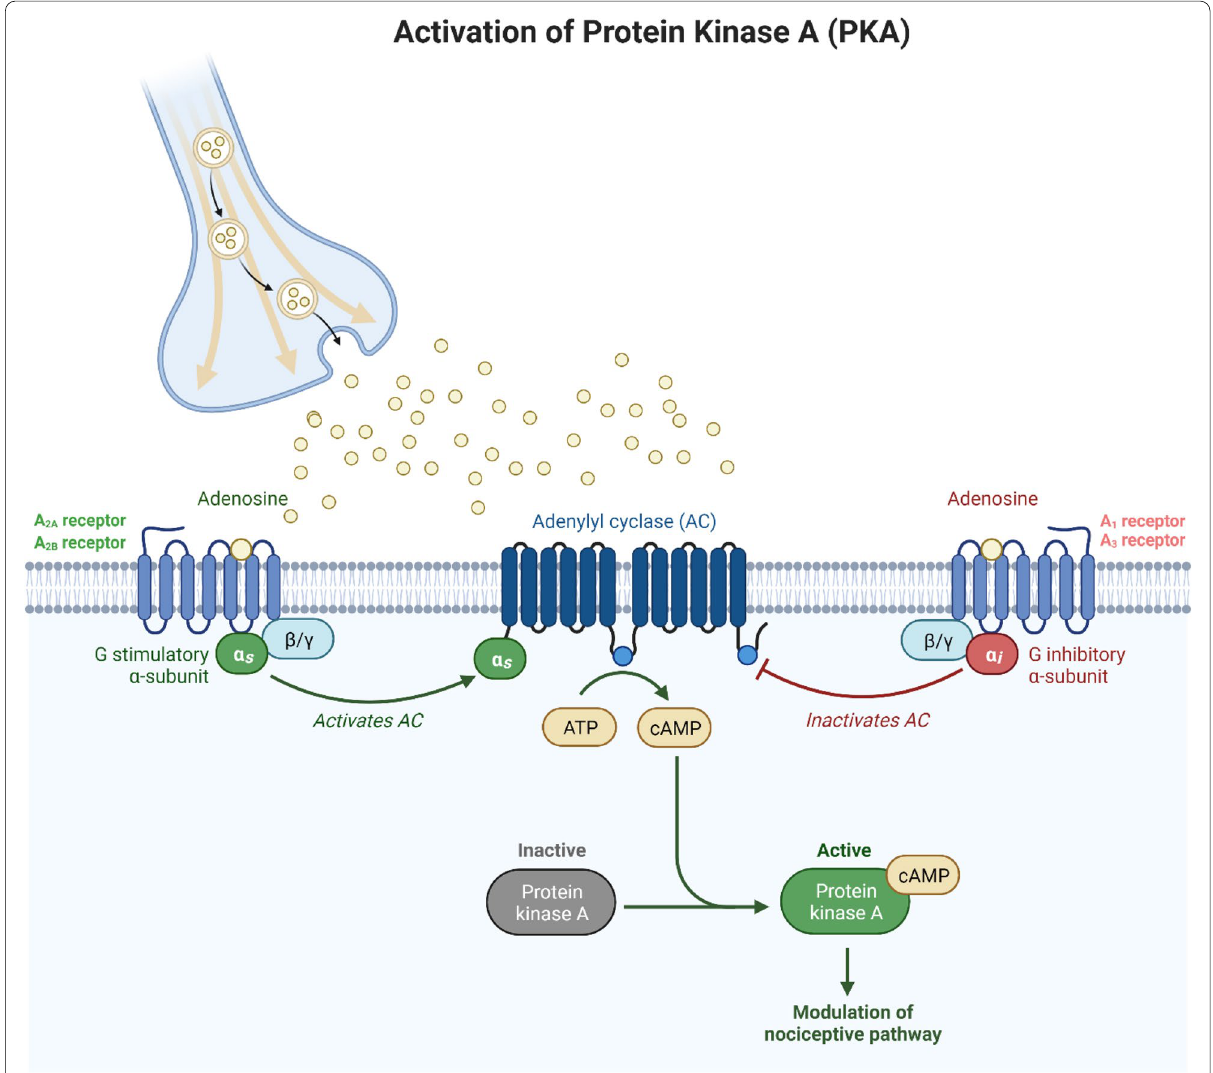
Fig. 1 Adenosine signaling pathway. Adenosine binds to G‑protein coupled receptors (GPCR) resulting in either activation (adenosine A 2A and A 2B receptors) or inactivation (adenosine A 1 and A 3 receptors) of adenylyl cyclase (AC). Activation of AC increases the formation of cyclic adenosine monophosphate (cAMP) which binds to protein kinase A (PKA). Active PKA then phosphorylates and thereby modulates cellular responses. ATP: adenosine